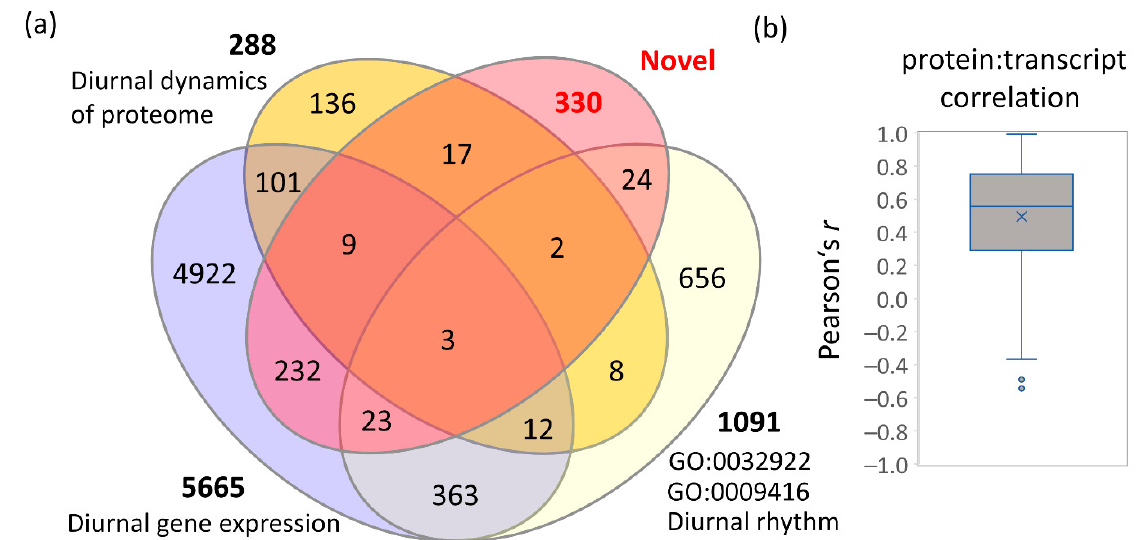
Figure 9. Novel targets of diurnal regulation in the Arabidopsis proteome. ( a ) A Venn diagram representing the overlap between the identified differentially abundant proteins and previously identified diurnally expressed genes and regulated proteins (based on https://www.arabidopsis.org/, accessed on 15 September 2022; https://www.uniprot.org/; accessed on 15 September 2022; [21,39]). For details, see Supplementary Table S1. ( b ) Pearson’s correlation between transcripts and the corresponding protein abundances. Based on data reported in the ATHENA database, accessed on 15 September 2022 [62].